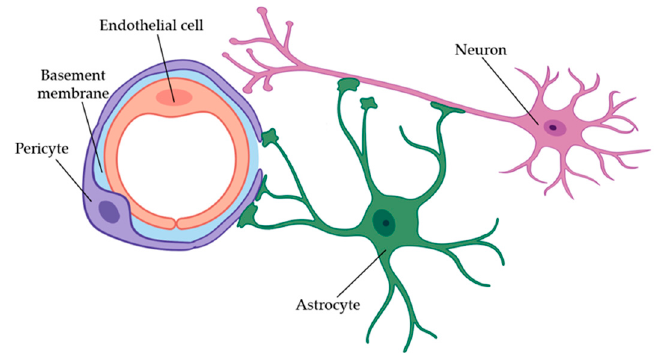
Figure 6. A simplified cross-sectional diagram showing the structure of a neurovascular unit in the brain and illustrating the cell–cell interactions. The innermost layer consists of the mircovessel endothelial cells surrounded by the basement membrane. Pericytes attach to and incompletely cover the basement membrane. The endfeet of astrocytes act as the outermost layer of the vascular structure and interact directly with the other cells of the neurovascular unit (NVU). Neurons can interact with the other cells either directly through their dendrites and subsequent synaptic space or through the astrocytes.